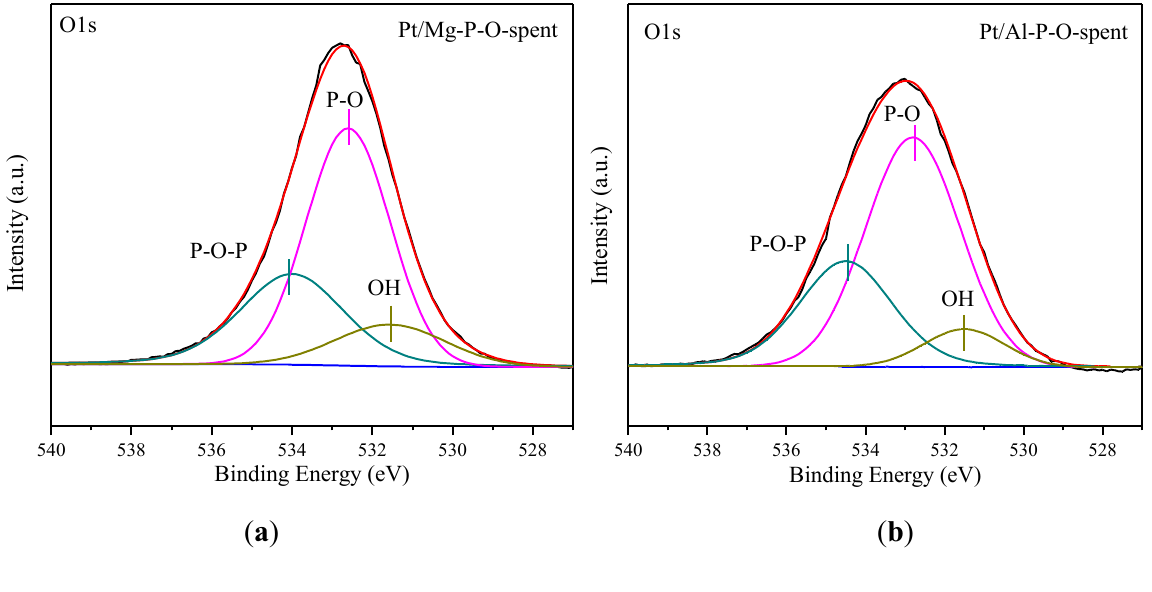
Figure 8. O1s XPS data of Pt/M-P-O catalysts collected after reaction testing. M = Mg ( a ), Al ( b ), Fe ( c ), Co ( d ), Zn ( e ), La ( f